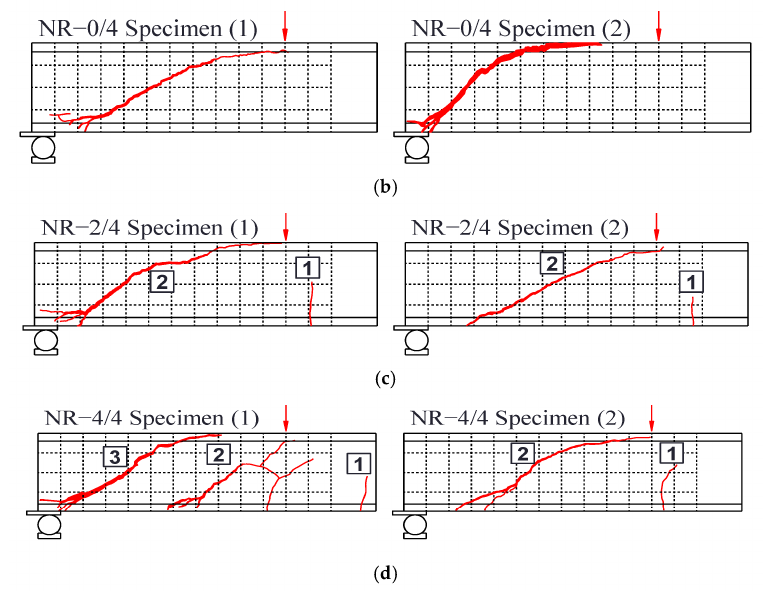
Figure 6. E ff ect of filled cores on shear strength of prestressed hollow core slab (PHCS). ( a ) Shear force-deflection responses. ( b ) Crack patterns of the NR-0 / 4 specimen. ( c ) Crack patterns of the NR-2 / 4